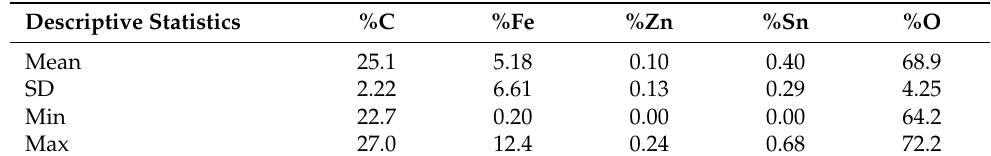
Table 5. Data about packaging microanalysis for main revealed elements: mean percentage values, standard deviation (SD), minimum (Min) and maximum (Max) values.